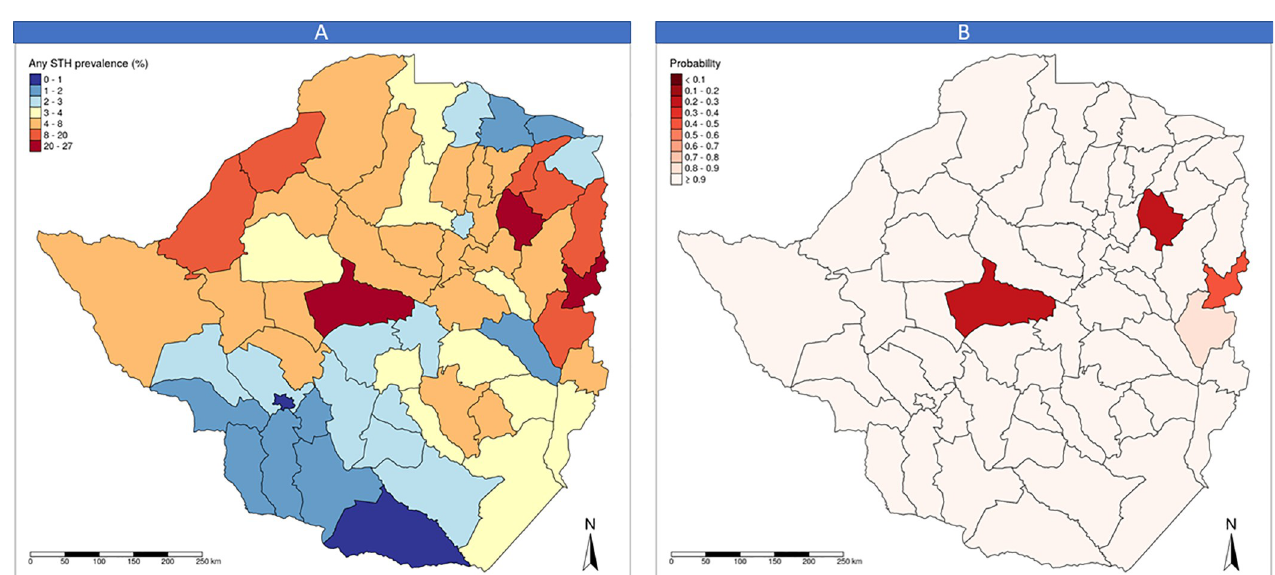
Fig 2. Maps presenting the results of baseline survey: (A) Predicted STH prevalence at baseline by district and (B) probability of a district being under the WHO threshold for intervention.